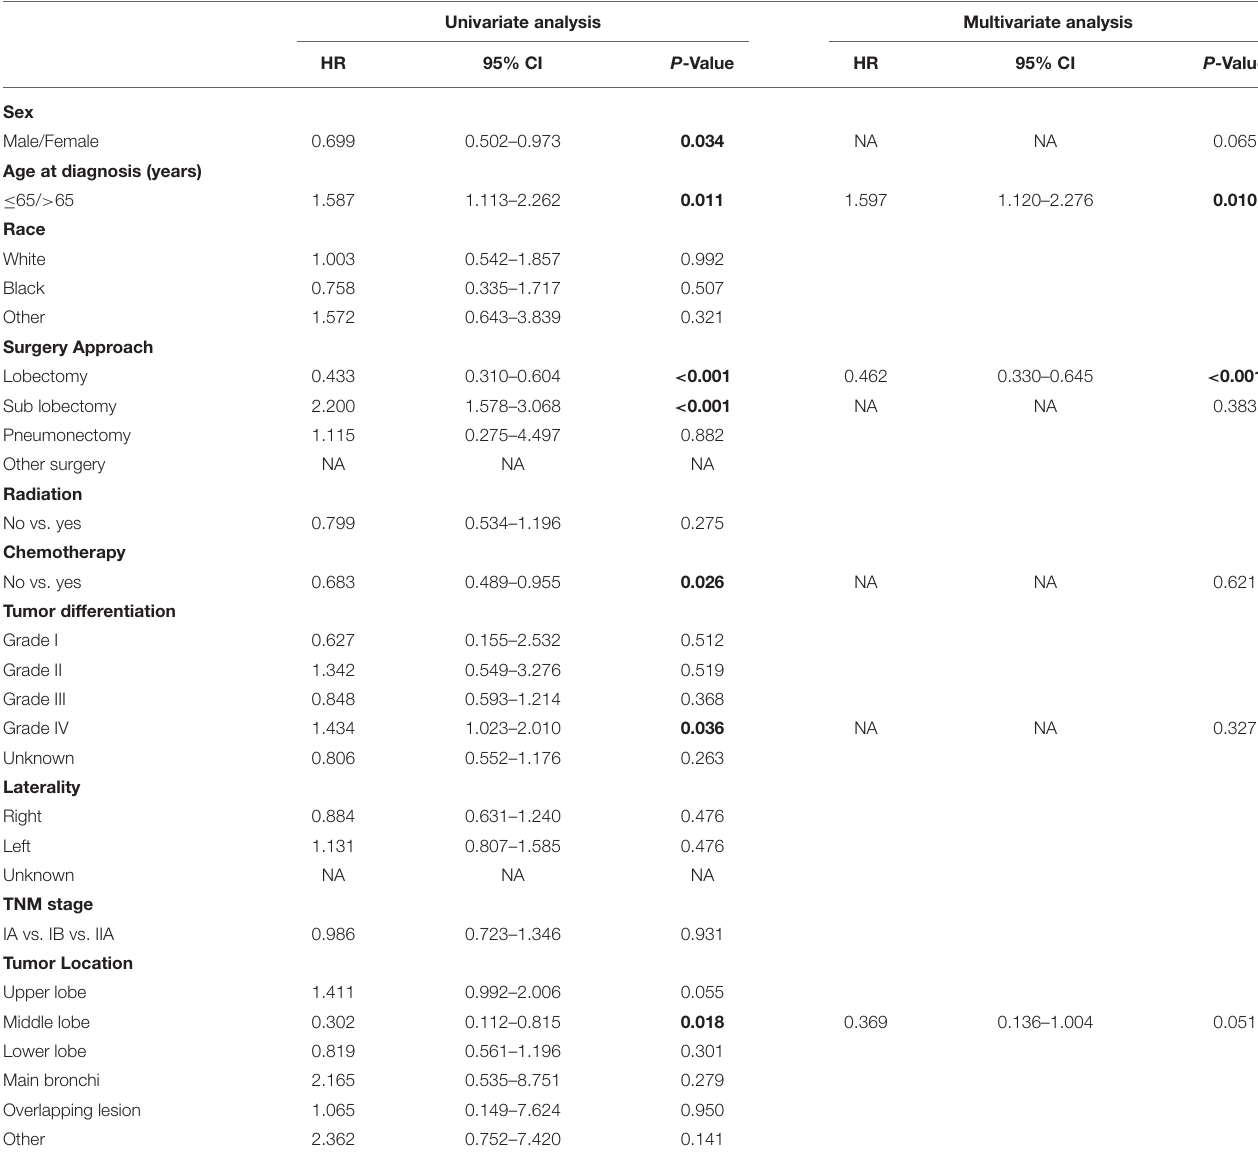
TABLE 5 | Univariate and multivariate Cox regression analysis for cancer-specific survival in patients with stage I-IIA SCLC who received surgery (Cox regression’s method is Forward: LR). Univariate